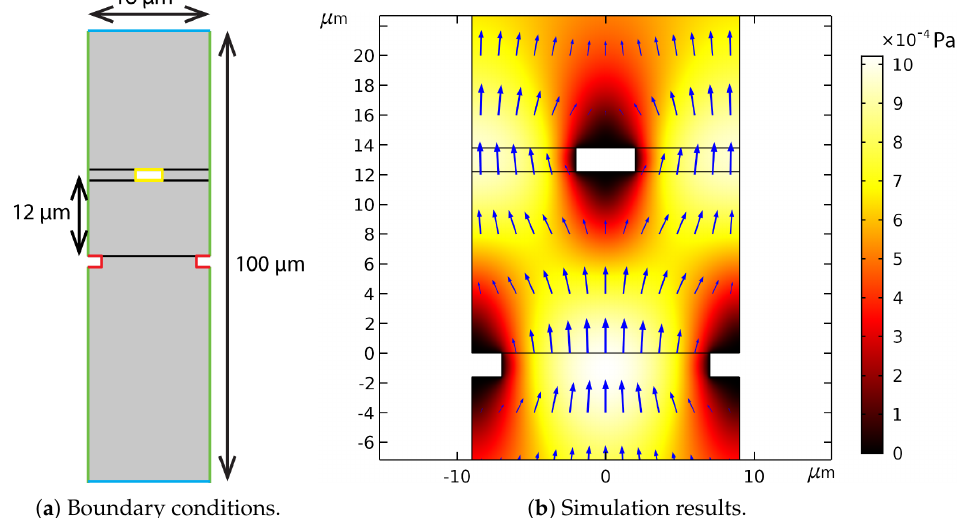
Figure 6. The domain of the 2D simulation ( a ) and the simulation result ( b ) of flow around the capacitive readout fingers. The gray area in ( a ) is the domain where fluid flow was simulated. The green lines indicate a symmetrical boundary condition. The blue lines indicate an open boundary condition. The red and yellow lines represent no-slip walls. The yellow rectangle represents a moving finger. The red lines represent the fixed fingers. The black lines separate the different domains of the moving mesh. The simulation results ( b ) show the flow and pressure when the moving finger has moved to the highest point and the velocity is zero. The color legend in ( b ) indicates the pressure. The blue arrows represent the flow velocity.